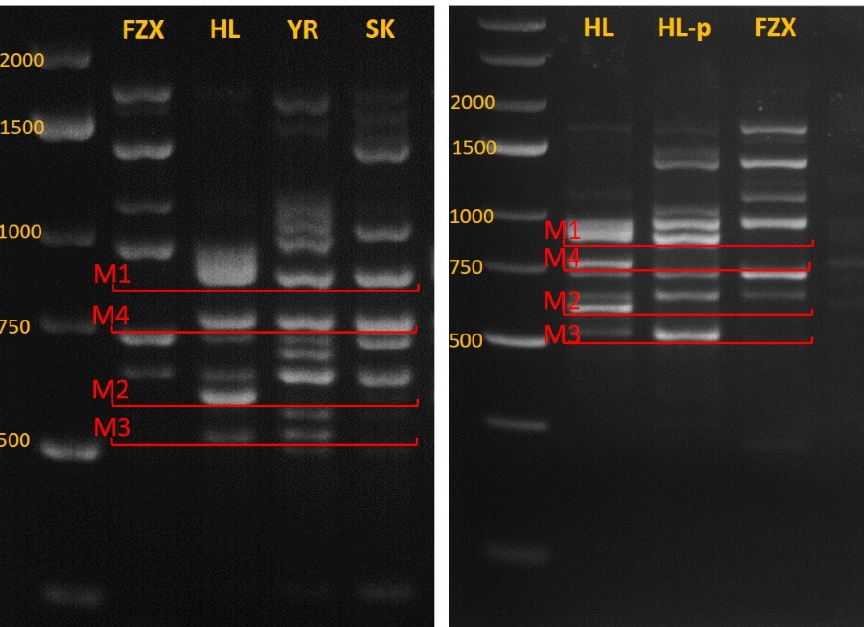
Figure 5. iPBS genetic fingerprints of different cultivars. Left—FZX and three potential pollinizers. Right—HL, HL-p = HL progeny, FZX.